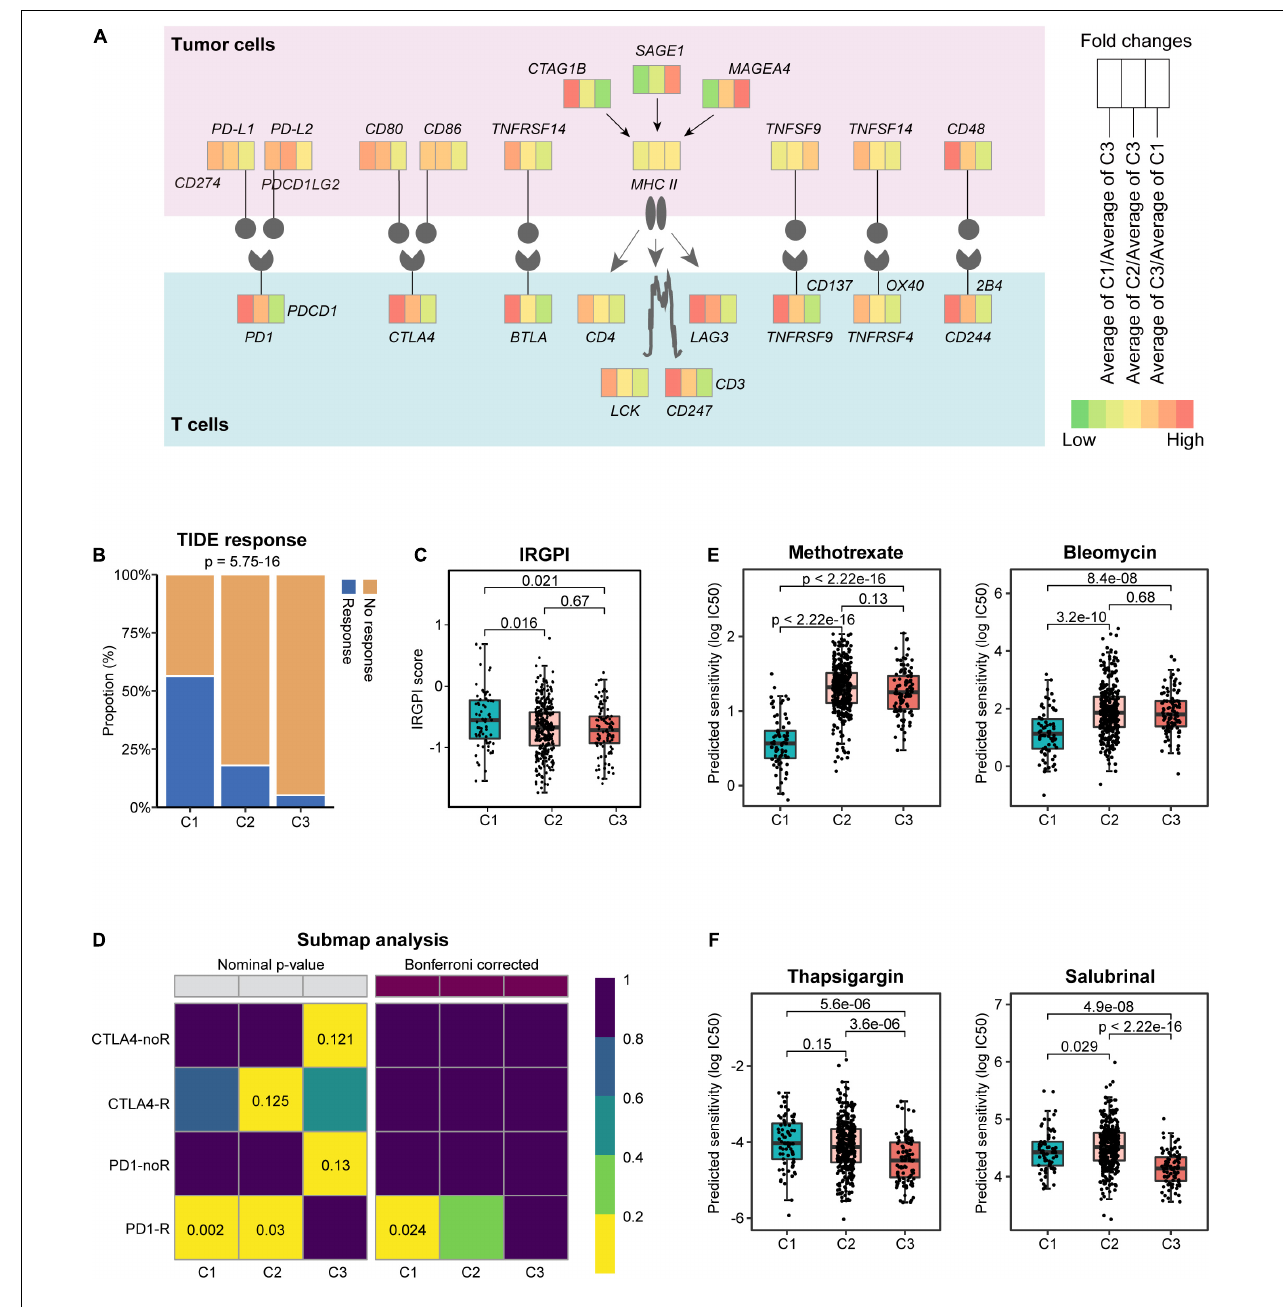
FIGURE 6 | Prediction of response to immunotherapeutic and therapeutic agents for different subtypes. (A) Diagram of the immune checkpoint pathway, comparing tumors in different subtypes. Tumor Immune Dysfunction and Exclusion (TIDE) response (B) and immune-related genetic prognostic index (IRGPI) score (C) in different subtypes. (D) Subclass mapping method (SubMap) analysis predicted the sensitivities of different subtypes to the four immune checkpoint inhibitors. noR, no response; R, response. The box plots depict the estimated IC50 for methotrexate, bleomycin (E) , and thapsigargin and salubrinal (F)